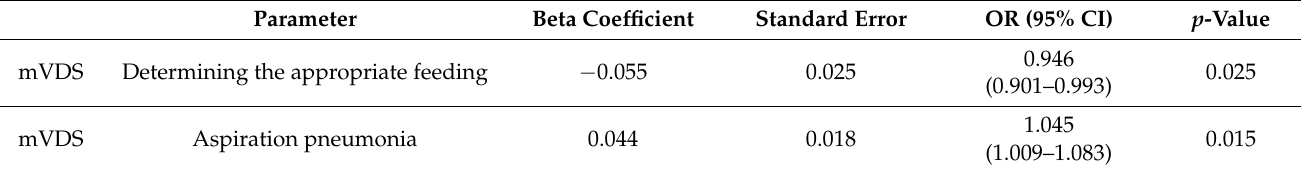
Table 5. Univariate logistic regression analysis (with the enter method) of the association between the modified version of the Videofluoroscopic Dysphagia Scale scores and the selection of the oral feeding method, and between the modified version of the Videofluoroscopic Dysphagia Scale scores and the development of aspiration pneumonia. Parameter Beta Coefficient Standard Error mVDS Determining the appropriate feeding − 0.055 mVDS Aspiration